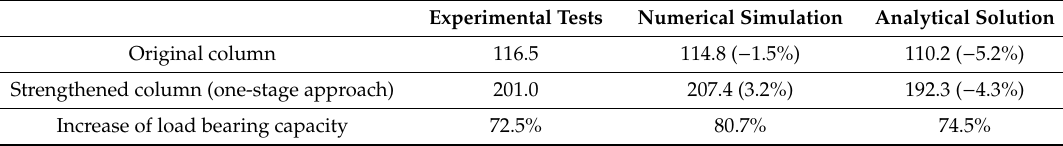
Table 2. Estimated load bearing capacities of columns in